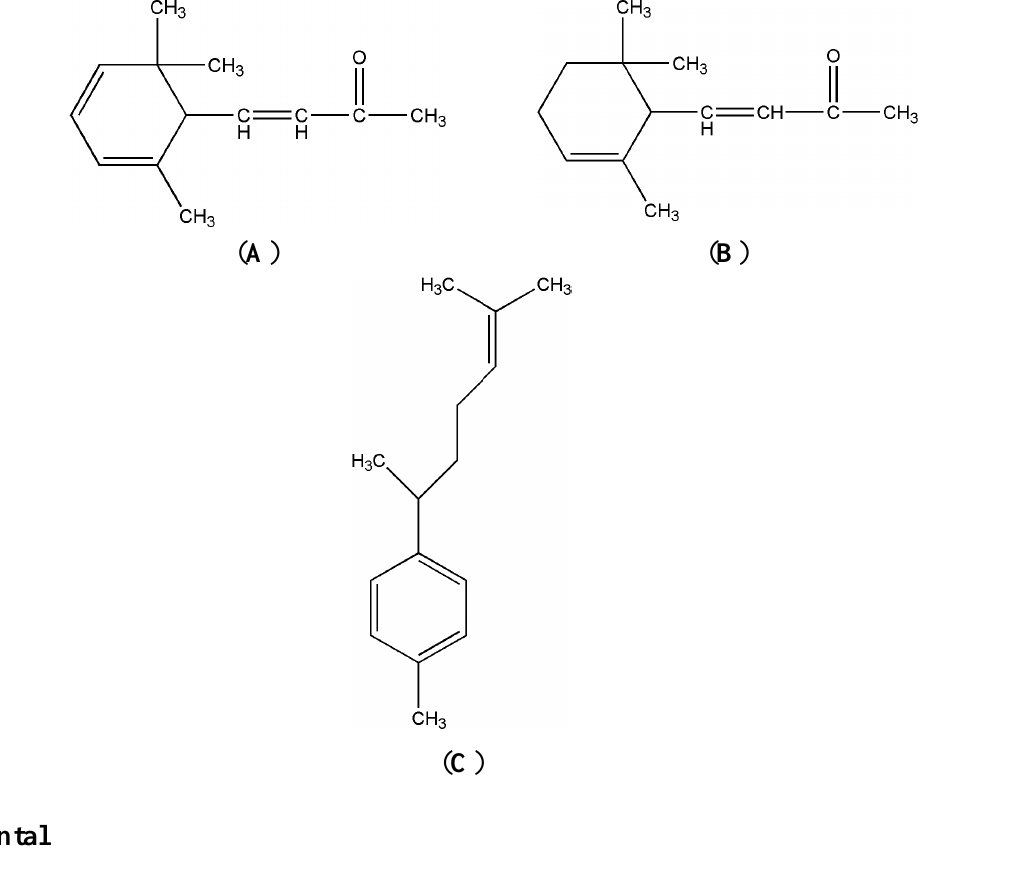
Figure 4. The structures of 2,3-dehydro-α-ionone ( A ), α-ionone ( B ) and curcumene ( C